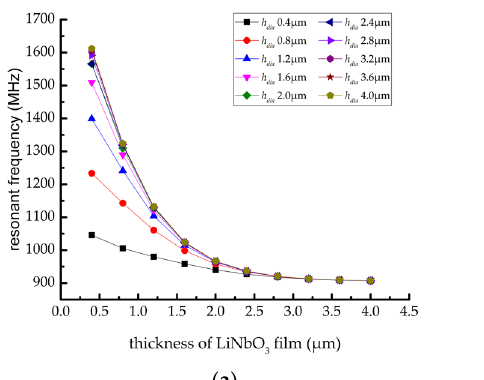
Figure 6. Variation curve of resonant and anti-resonant frequency ( a ) resonant frequency and ( b ) anti-resonant frequency.